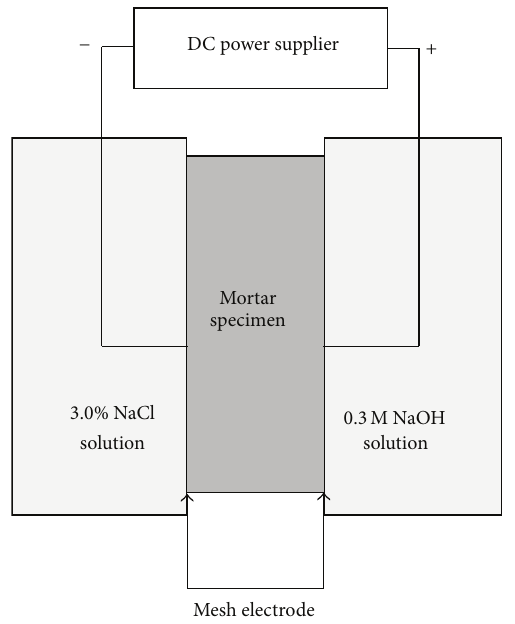
Figure 1: Set-up for rapid chloride ion penetration test.